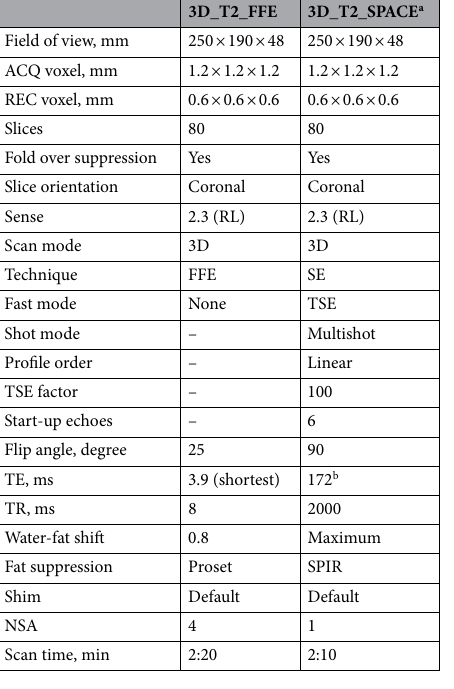
Table 1. Parameters of the 2 MRI sequences. FFE, fast field echo; NSA, number of signals averaged; SE, spin echo; SPIR, spectral presaturation inversion recovery; TSE, turbo spin echo; Proset, principle of selective excitation technique; ACQ, acquisition; REC, reconstruction; RL, right to left direction. a 3D view, MSK T2 FS. b TEequiv, 70